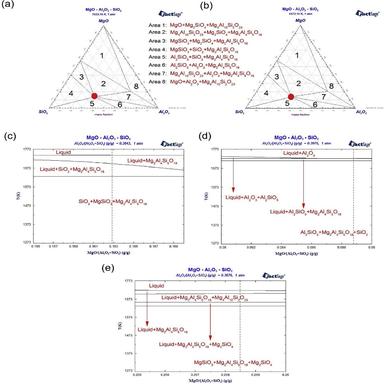
The phase diagrams of Al2O3–SiO2–MgO ternary system at (a) 1250 °C, (b) 1300 °C, and the crystalline phases precipitated at different temperatures calculated by Factsage. (c) S-3, (d) S-1, and (e) S-5.